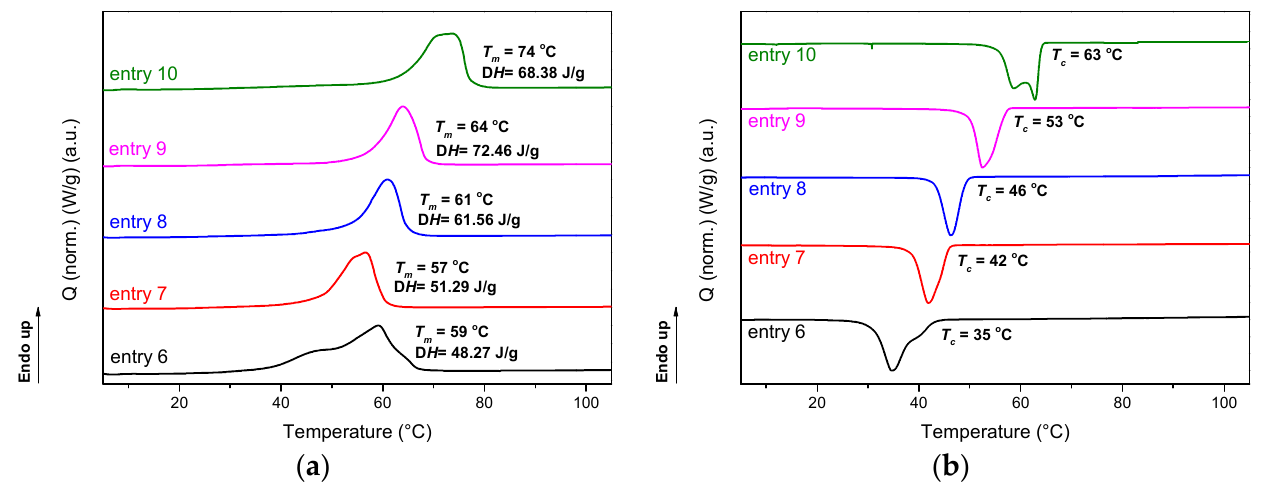
Figure 5. DSC thermograms: ( a ) second heating cycles and ( b ) first cooling scan of the TBHM-based polyester samples (entries 6 to 10 of Table 1).